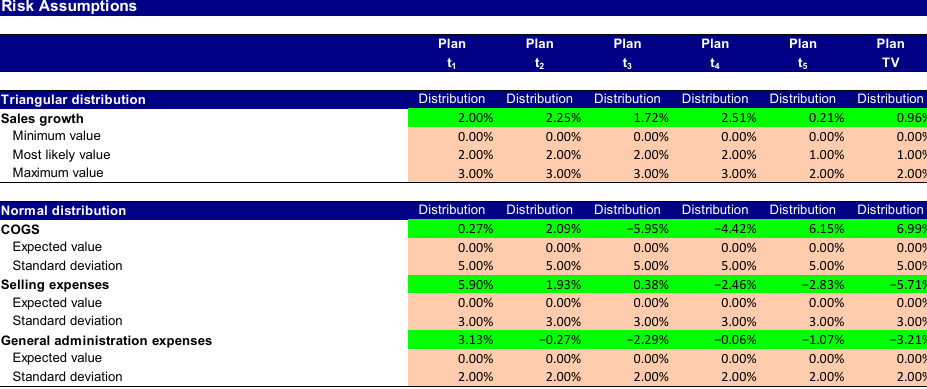
Figure 1. Distribution functions for modelling total sales, COGS, and general administrative expenses.